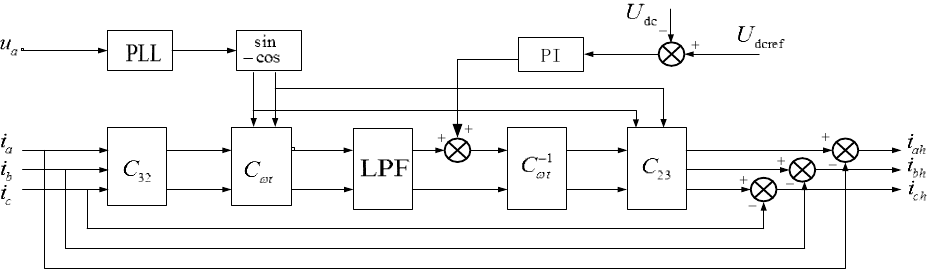
Figure 9. Harmonic detection schematic.